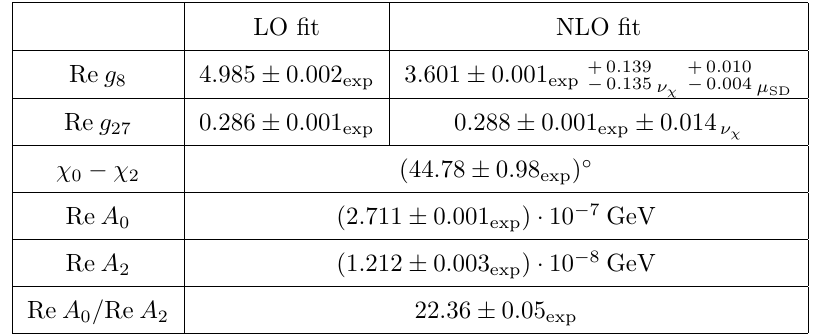
Table 7 . LO and NLO (cid:12)ts to the K ! (cid:25)(cid:25) amplitudes in the limit of isospin conservation.